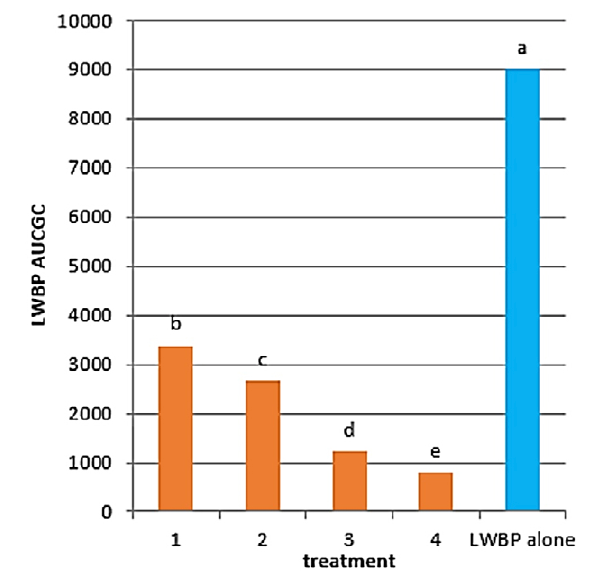
Figure 6. Mean concentrations of lime witches’ broom phytoplasma (LWBP) in four mixed infections and a single infection in peri- winkle plants, based on areas under concentration growth curves (AUCGC). 1, LWBP (16SrII-B) + rapeseed phyllody phytoplasma (RPhP) (16SrI-B); 2, LWBP + tomato witches’ broom phytoplasma (TWBP) (16SrII-D); 3, LWBP + alfalfa witches’ broom phytoplasma (AWBP) (16SrII-C); and 4, LWBP + sesame phyllody phytoplasma (SPhP) (16SrIX-C). Means were compared using Duncan Multiple Range Test. Means accompanied by different letters are significantly different ( P ≤ 0.05).